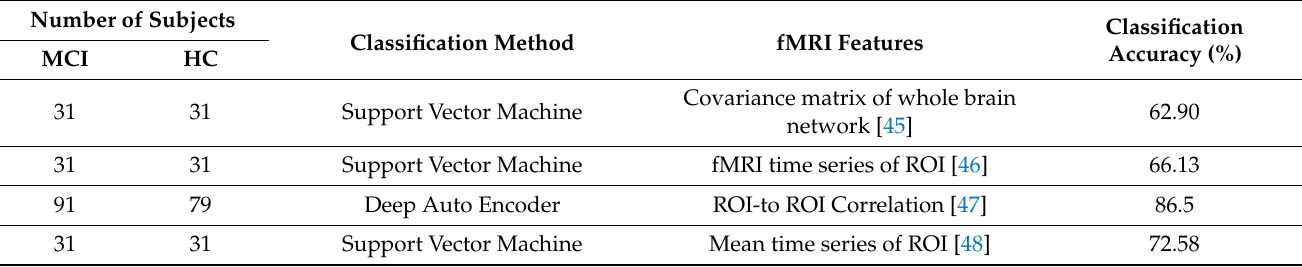
Table 12. Comparison of HC versus MCI classification with recent